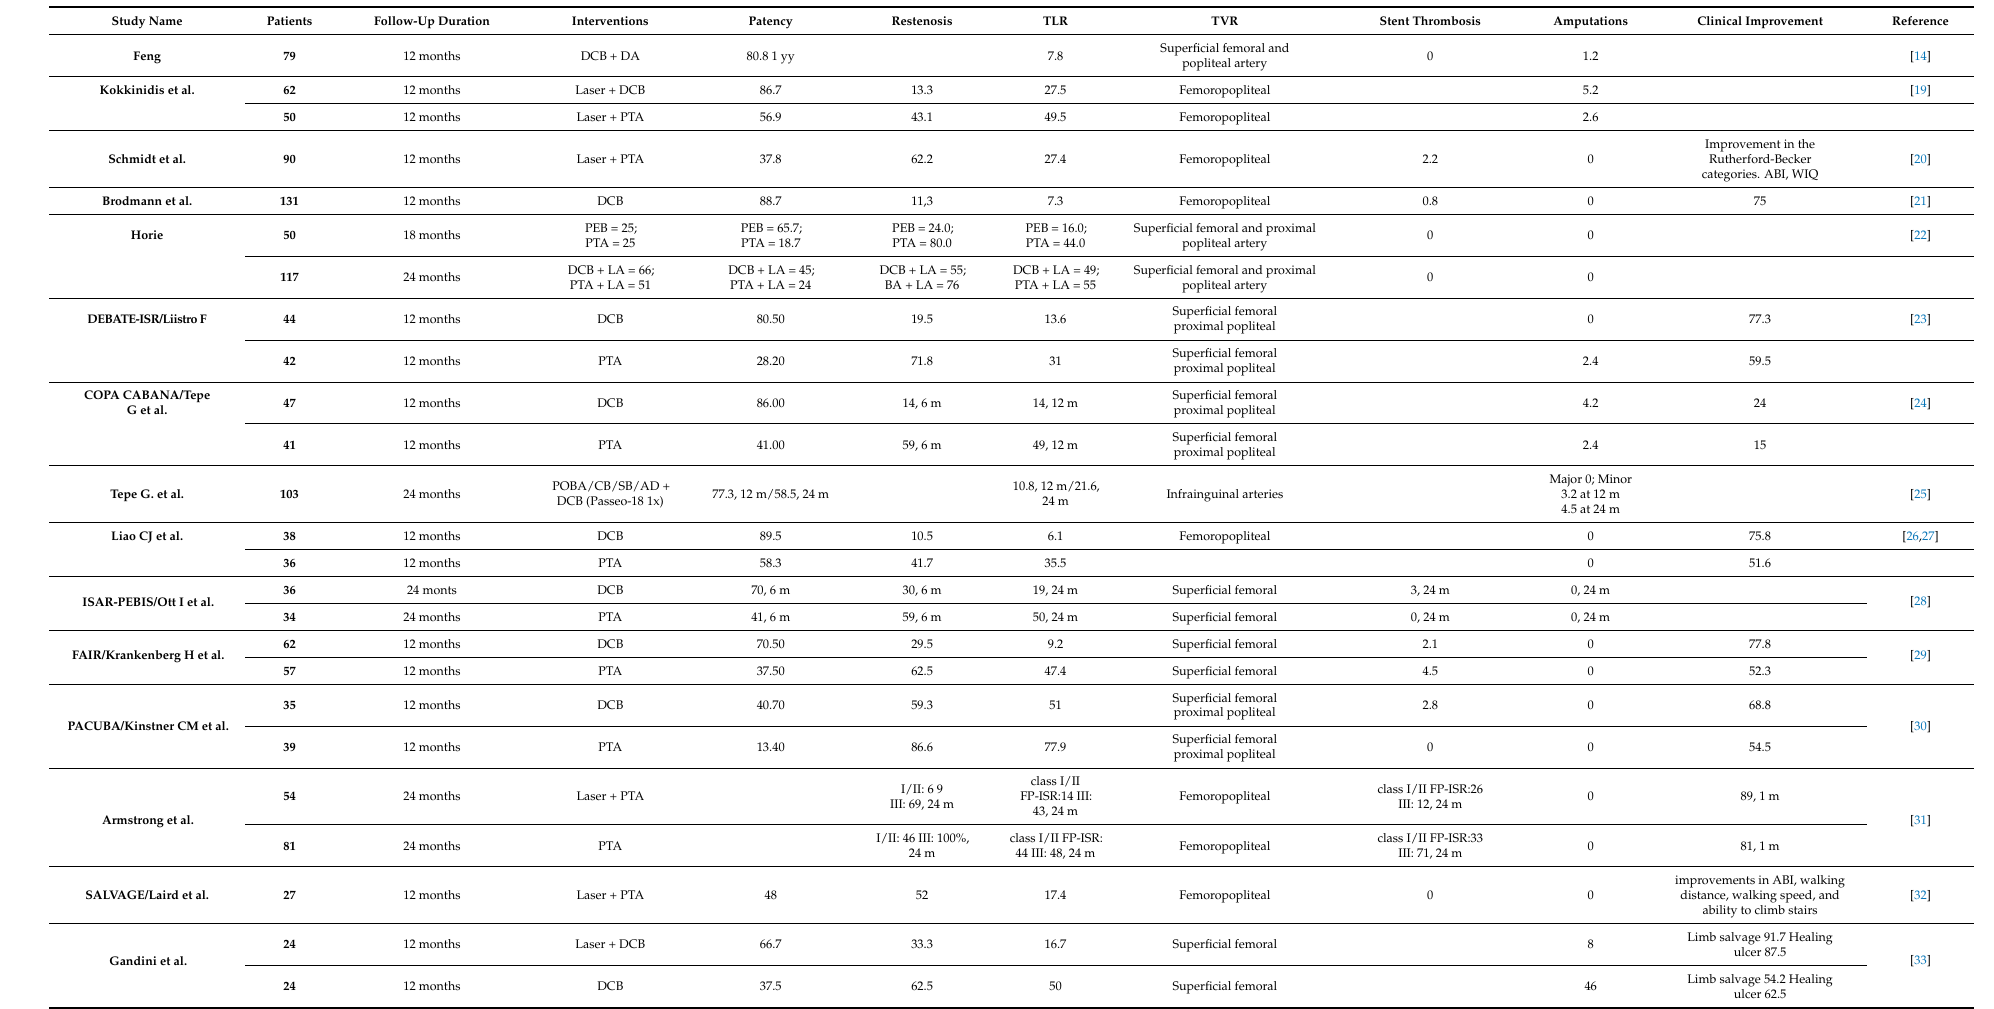
Table 3. Summary of study